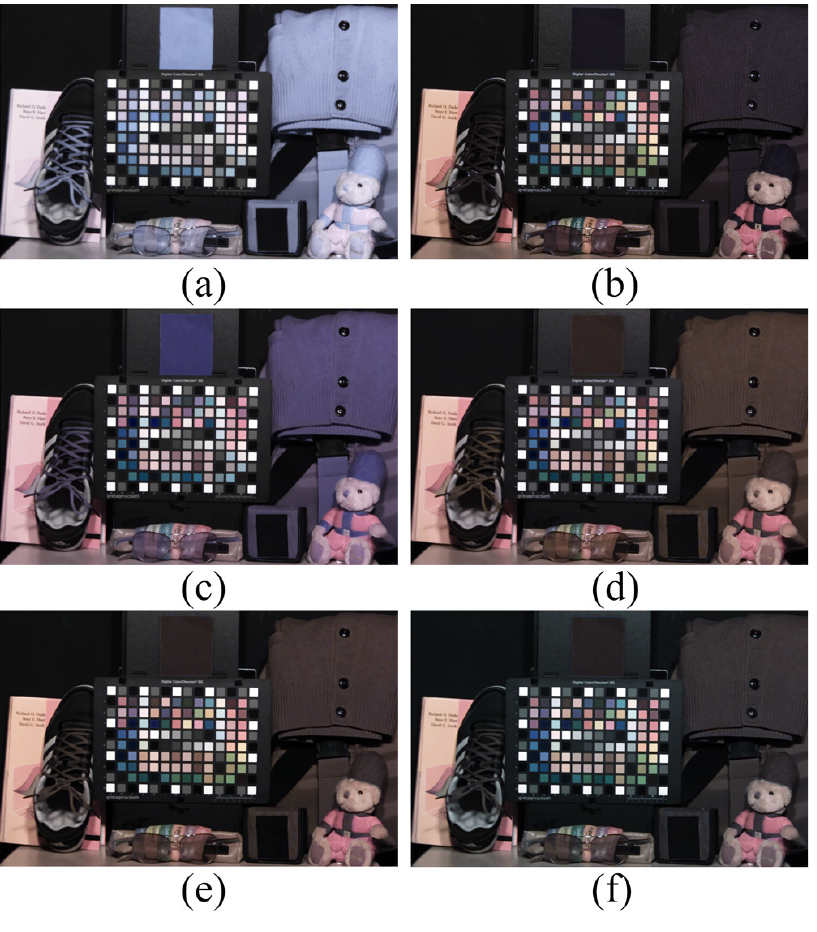
Figure 19. Experimental results under an incandescent lamp (200 lx). ( a ) Input image; ( b ) optical filtered visible band image; ( c ) 3 × 3 CCM; ( d ) 3 × 4 CCM; ( e ) root-polynomial mapping; ( f ) proposed